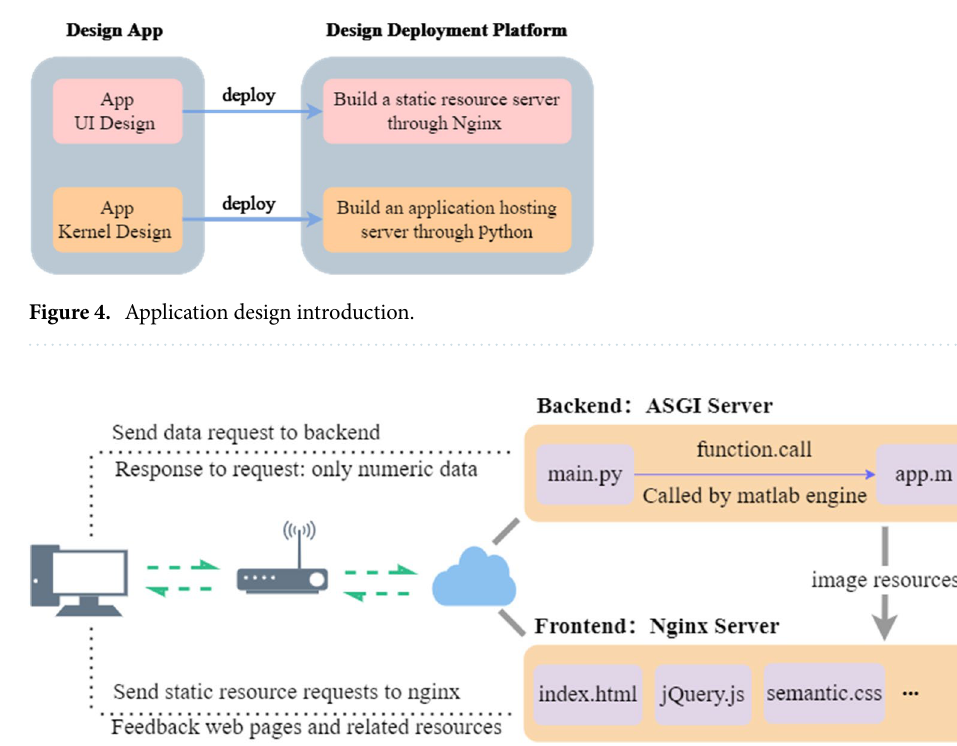
Figure 5. General architecture of MATLAB Web App Server replacement